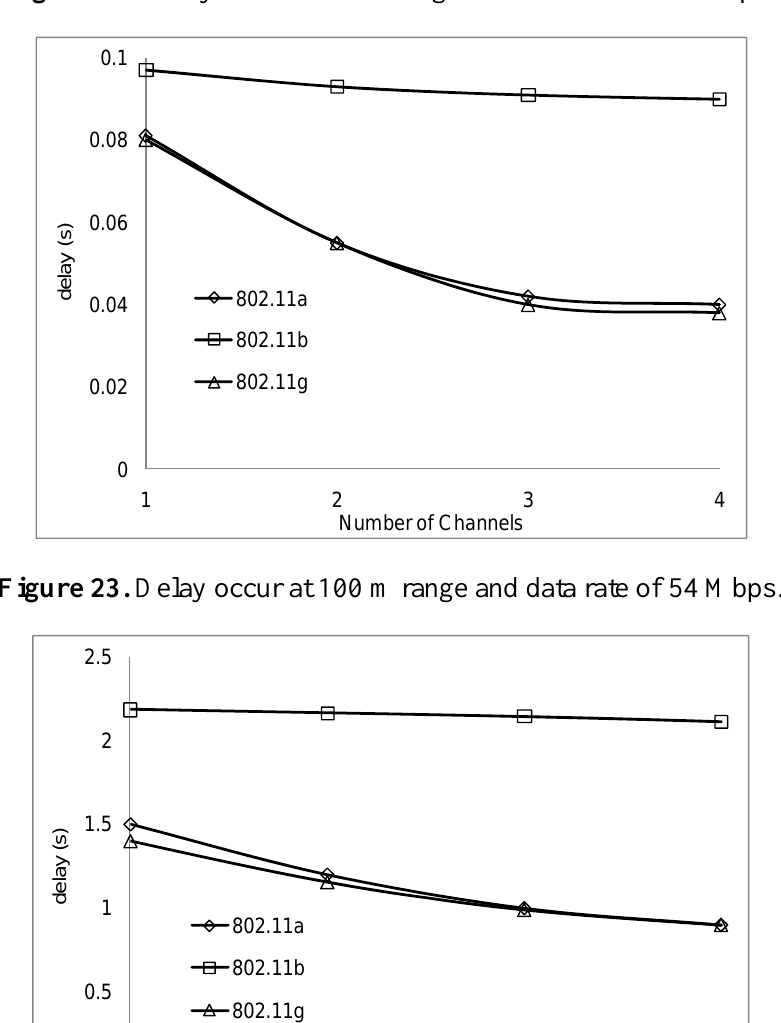
Figure 22. Delay occur at 50 m range and data rate of 54 Mbps.